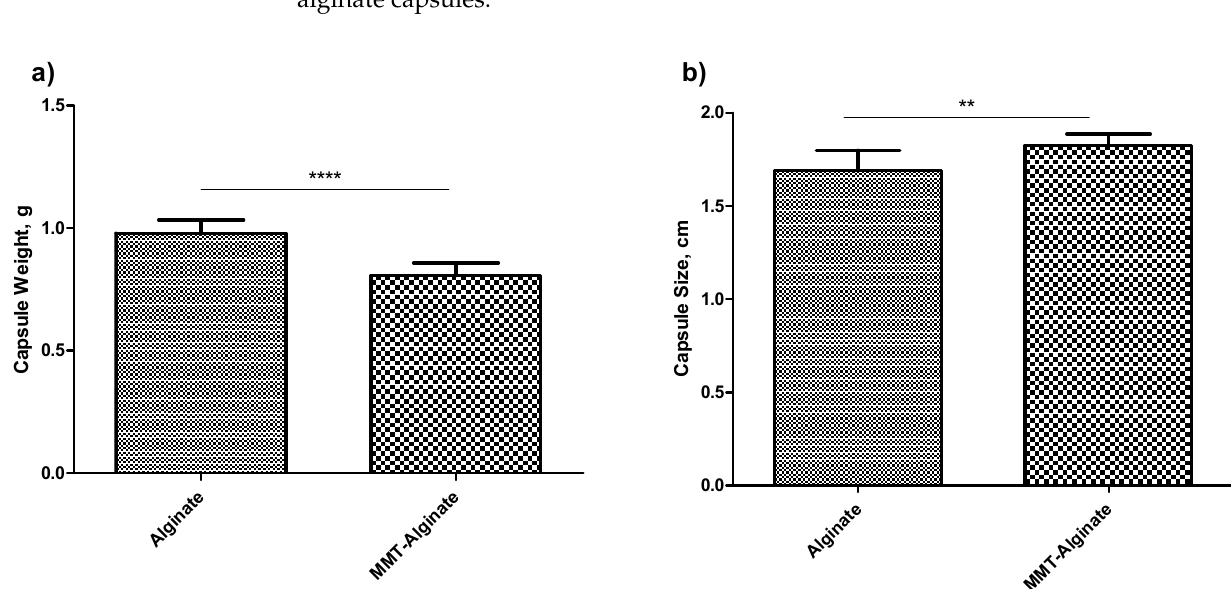
Figure 2. Effect of addition of MMT. ( a ) Comparison of weight variation between alginate capsule and MMT-enhanced alginate capsules ( n = 12, ± SD). ( b ) Comparison of size variation between the alginate capsules and MMT-enhanced alginate capsules ( n = 12, ± SD). Signs **** and ** represents a significant difference.